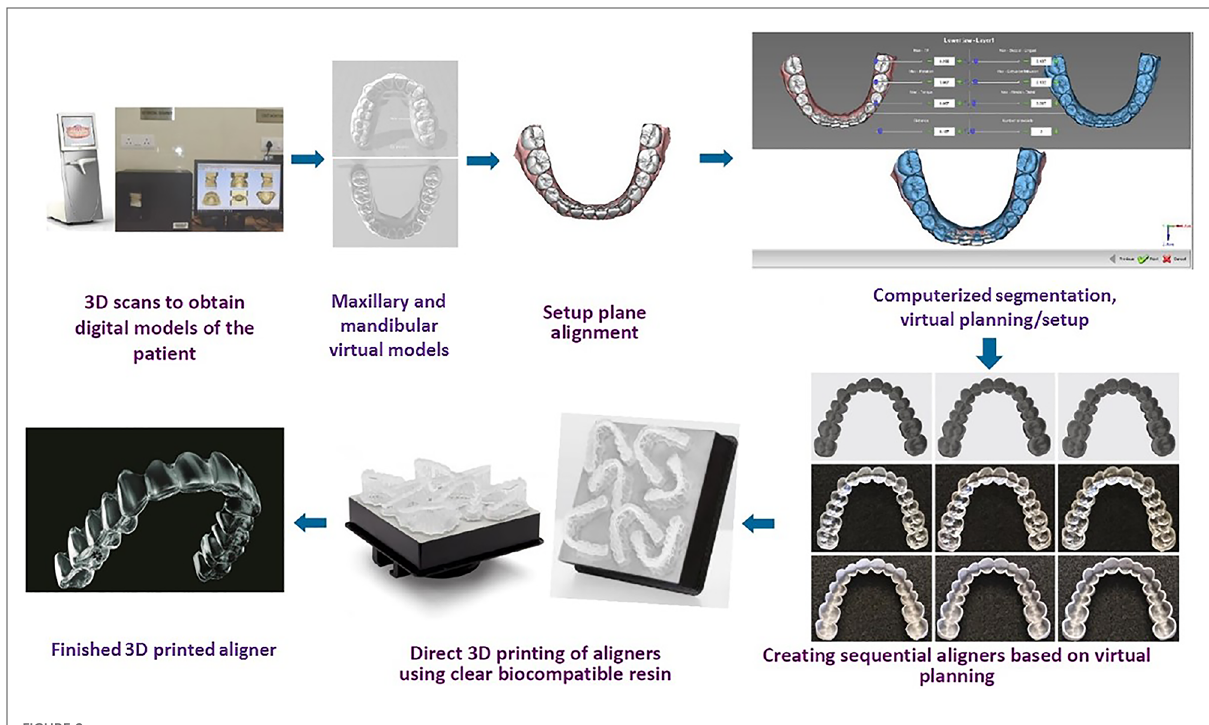
FIGURE 2 The key stages of laboratory procedure in the manufacturing of direct 3D-printed clear